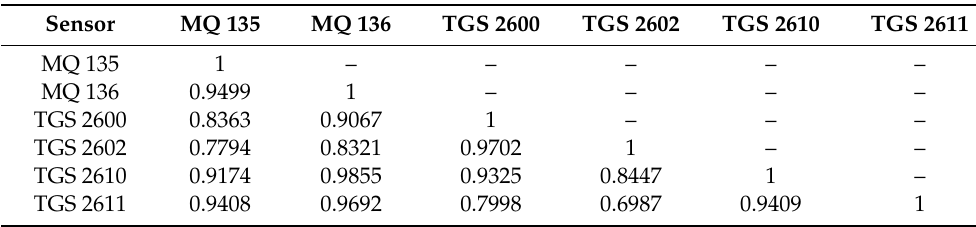
Table 2. Correlation coe ffi cient between